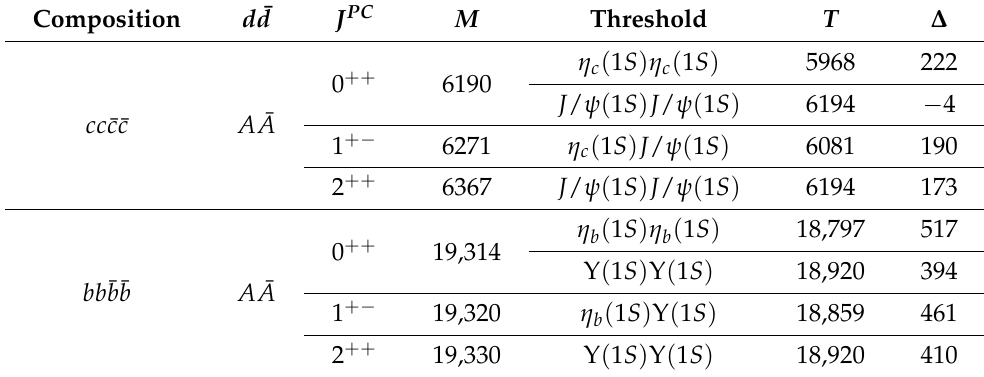
Table 9. Masses M of the neutral heavy diquark ( QQ )–antidiquark ( ¯ Q ¯ Q ) states. T is the threshold for the decays into two heavy-( Q ¯ Q ) mesons and ∆ = M − T . All values are given in MeV.